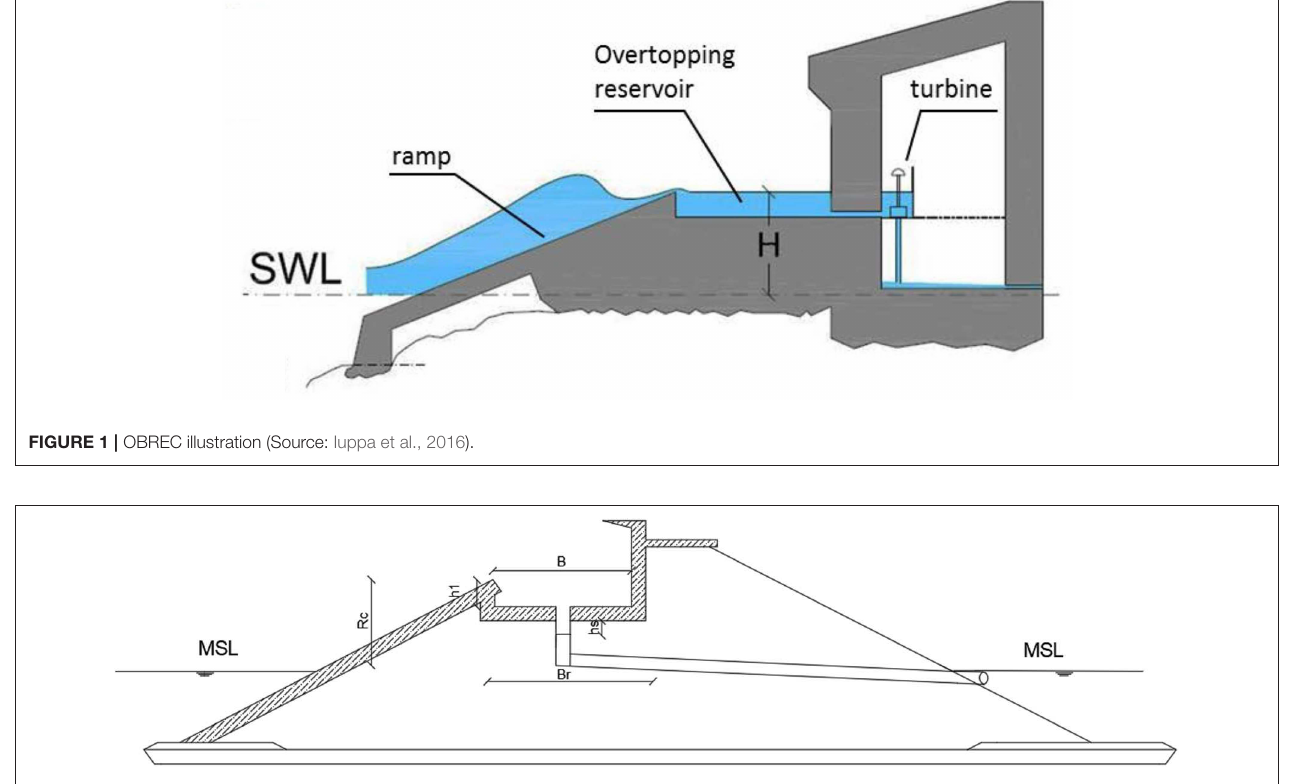
FIGURE 2 | Depiction of OBREC